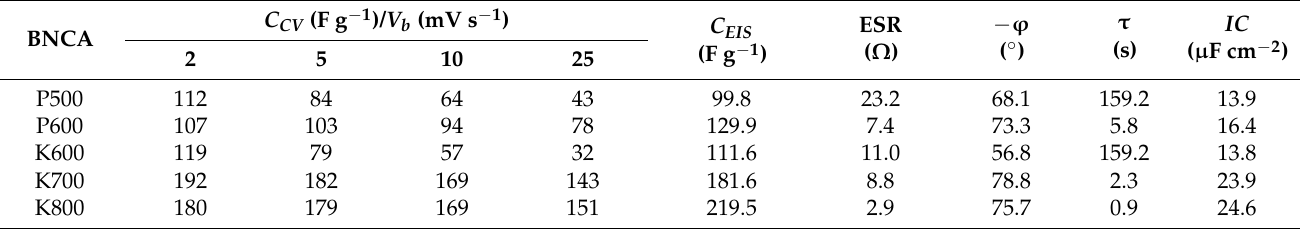
Table 3. Electrochemical properties of BNCAs determined by cyclic voltammetry and electrochemical impedance